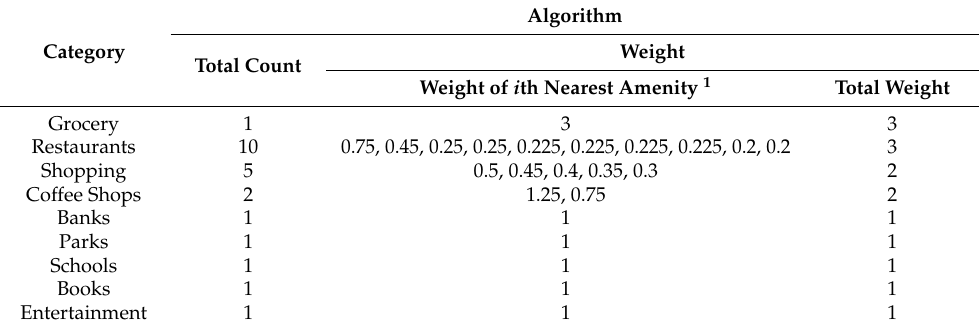
Table 1. Walk Score